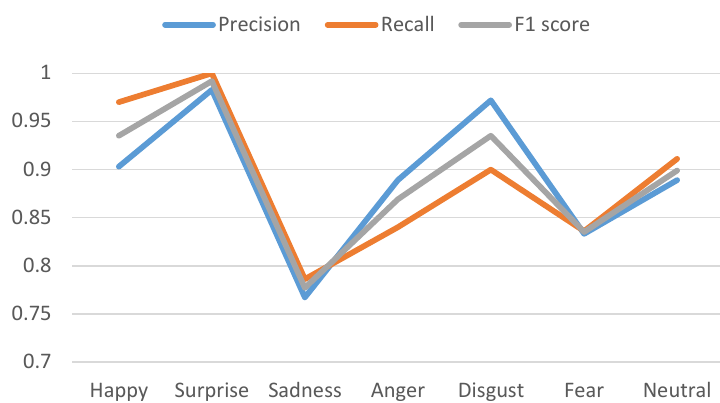
Figure 14. Dataset: KDEF, Precision, Recall, and F1 score is shown for SVM.